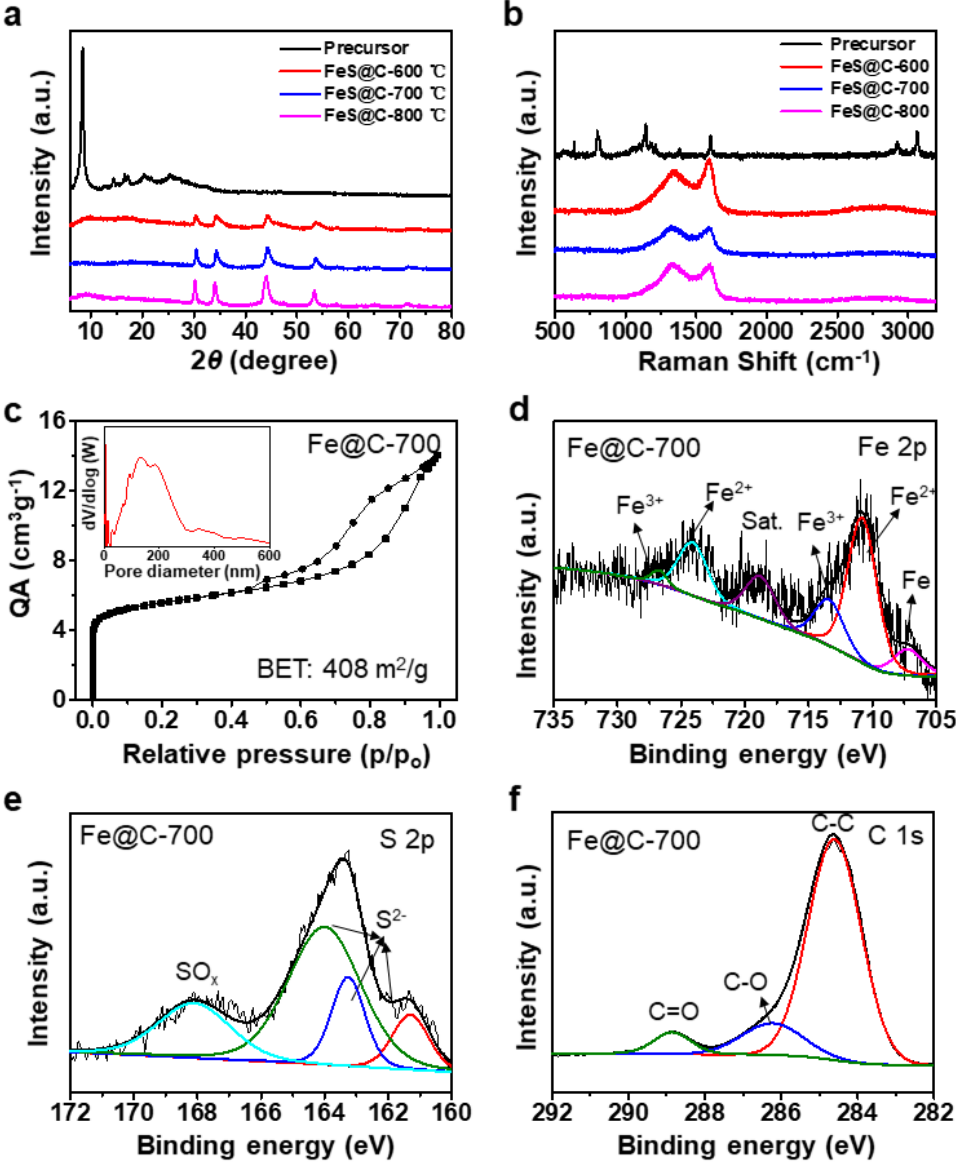
Figure 2. ( a ) The XRD patterns and ( b ) Raman spectra of the precursor, FeS@C-600, FeS@C-700, and and FeS@C-800 particles. ( c ) Nitrogen adsorption / desorption isotherms and corresponding FeS@C-800 particles. ( c ) Nitrogen adsorption/desorption isotherms and corresponding pore-size distribution (inset in Figure 2c) for the FeS@C-700 particles. ( d – f ) High-resolution X-ray photoelectron spectroscopy (XPS) spectra of Fe 2p, S 2p, and C1s for the FeS@C-700 particles.